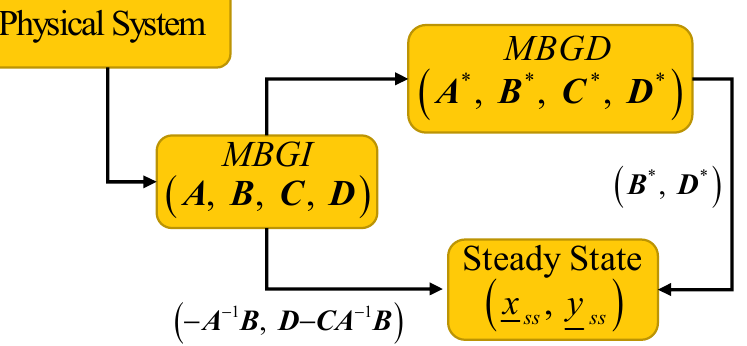
Figure 2. Steady state comparison via a multibond graph in an integral causality assignment (MBGI) and the traditional approach. MBGD, multibond graph in a derivative